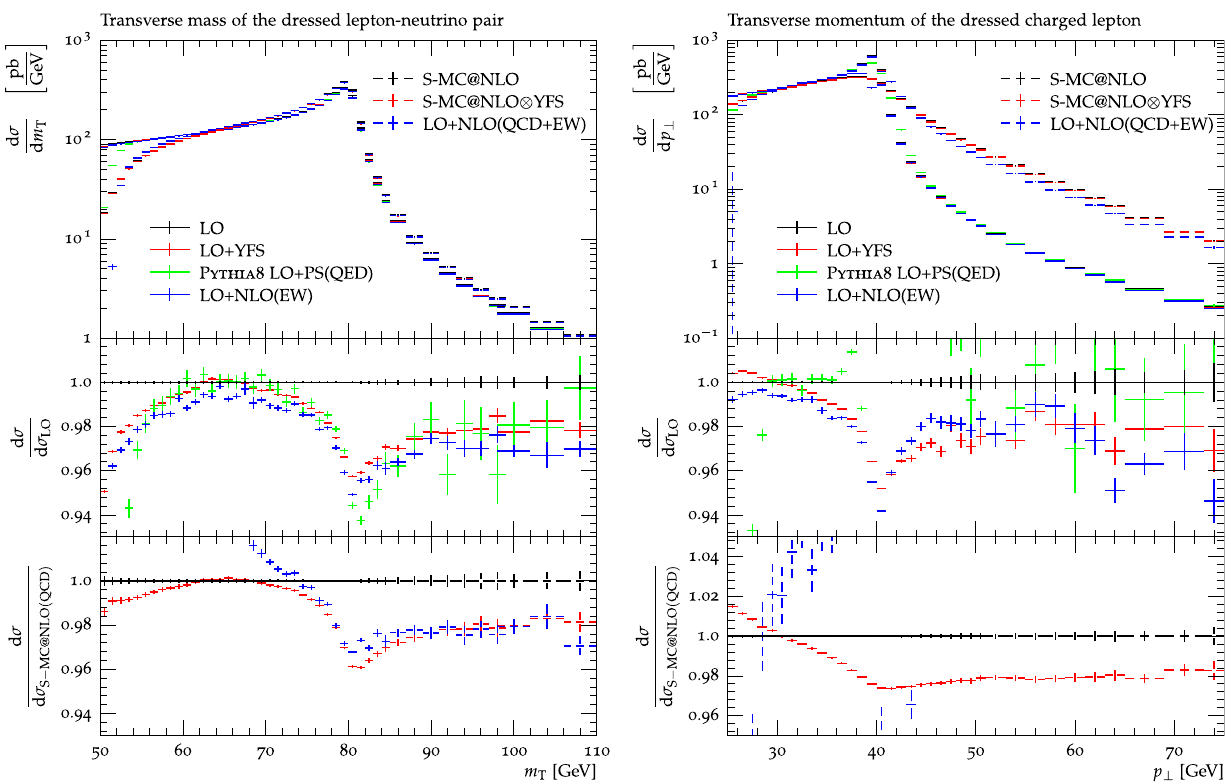
Fig. 38 Comparison of the description of the transverse mass of the dressed electron-neutrino pair ( left ) and the dressed electron transverse momentum ( right ) in electron-neutrino-pair production in the CC DY process with fiducial cuts (see text for more details)